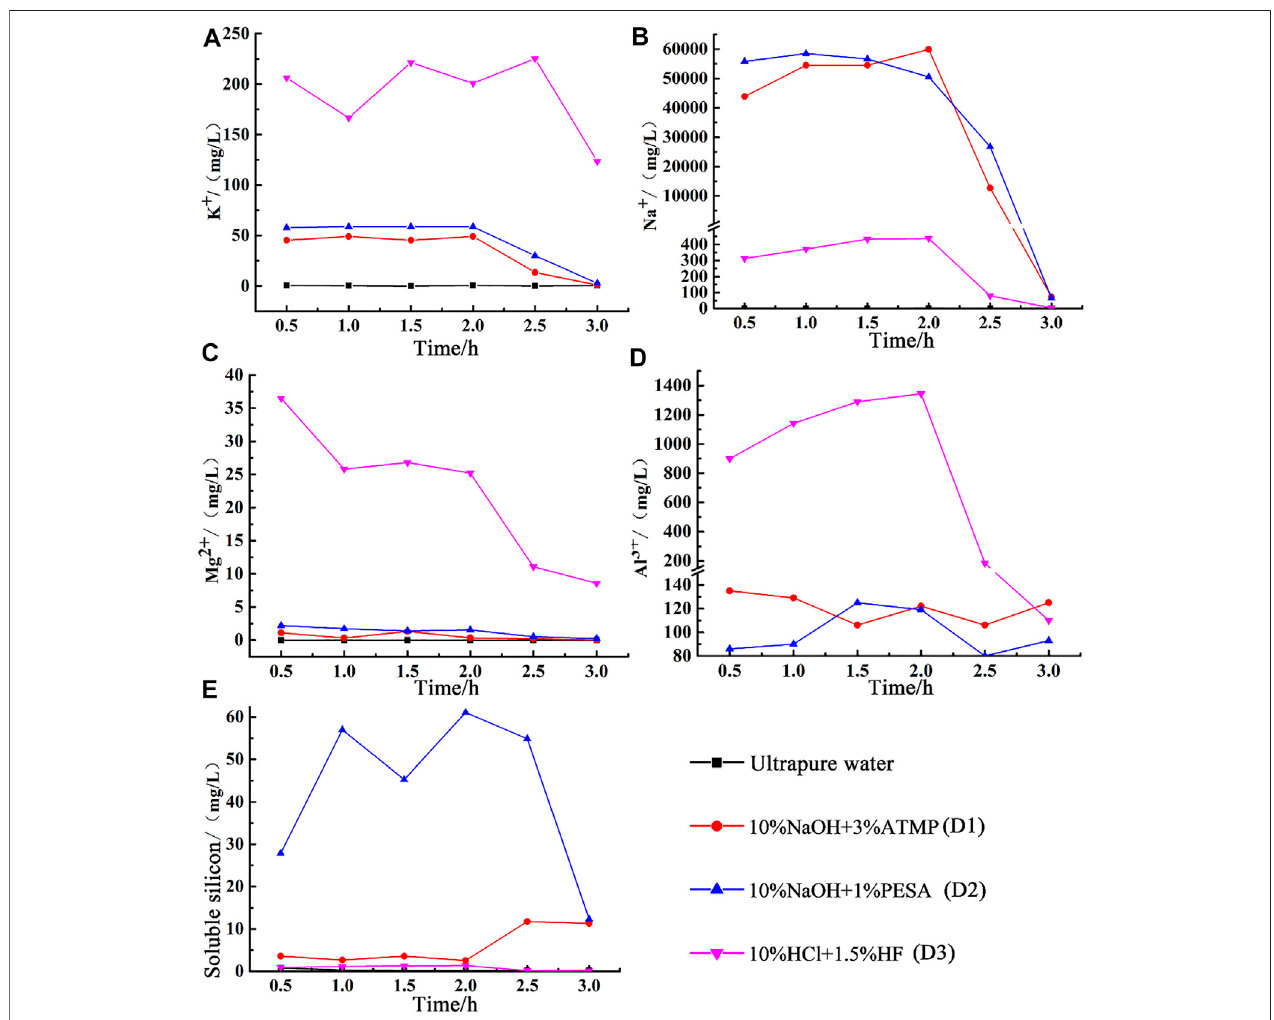
FIGURE 6 | Changes of chemical composition of the dynamic experiment. (A) Concentration of K + ; (B) concentration of Na + ; (C) concentration of Mg 2+ ; (D) concentration of Al 3+ ; (E) concentration of soluble silicon.